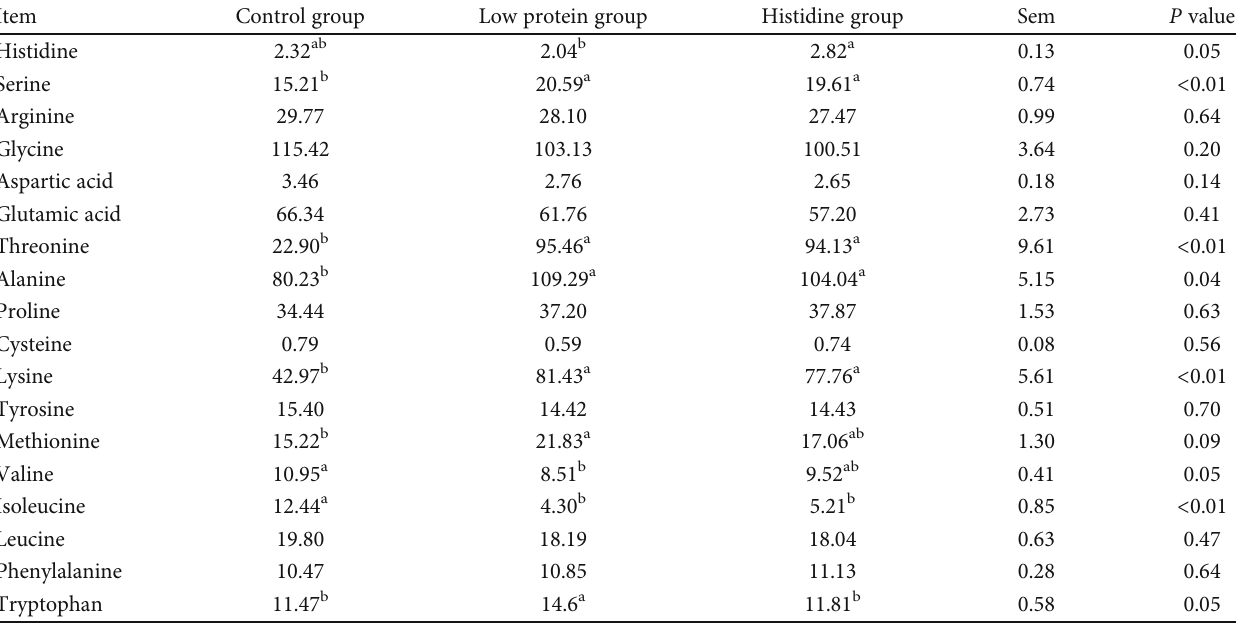
Table 4: E ff ect of dietary histidine on serum amino acid pool in low protein diet-fed piglets.